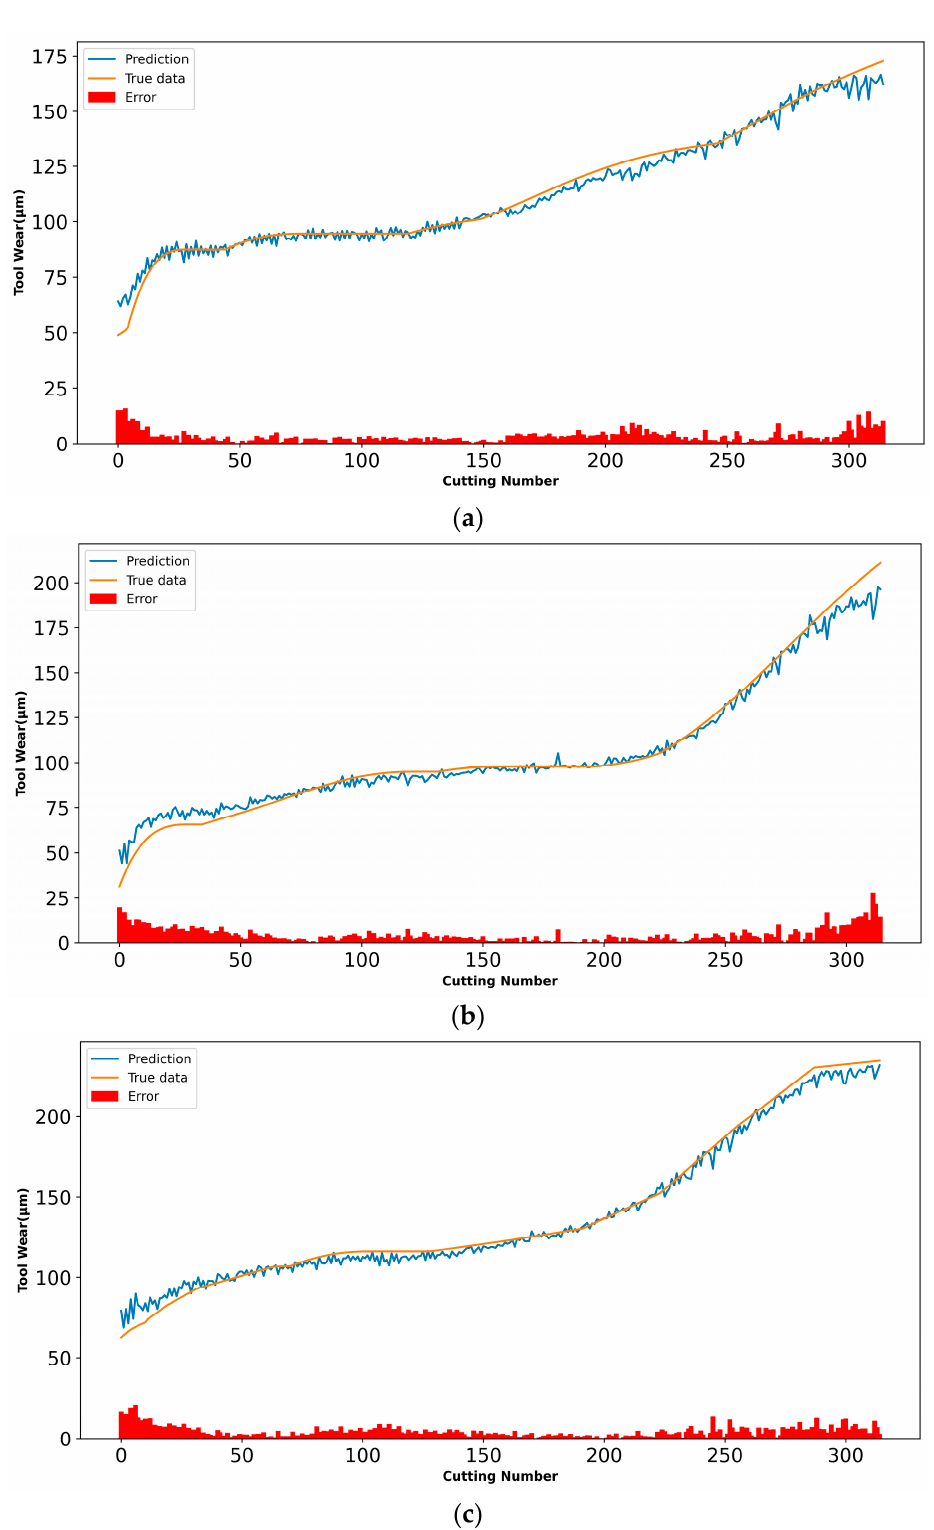
Figure 11. Comparisons between the predicted tool wear and the ground-truth tool wear: ( a ) C1 cutter, ( b ) C4 cutter, and ( c ) C6 cutter.